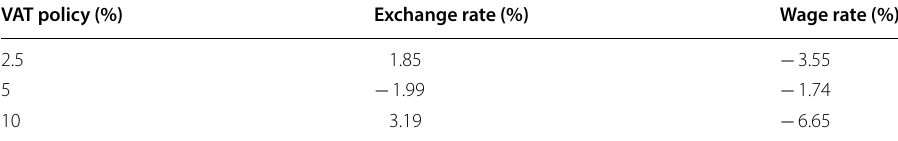
Table 4 Percentage changes in exchange rate and wage rate. Source: Model simulation VAT policy (%)